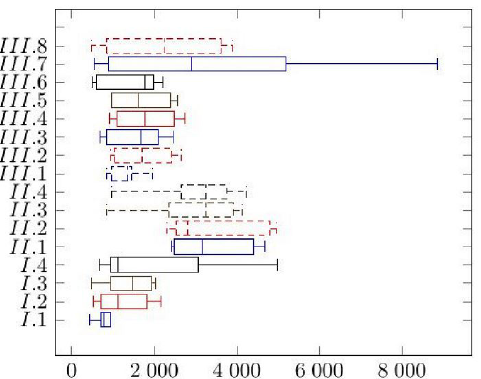
Figure 7. Dissipated hysteretic energy in KJ for the 16 different wall configurations, subjected to a series of selected